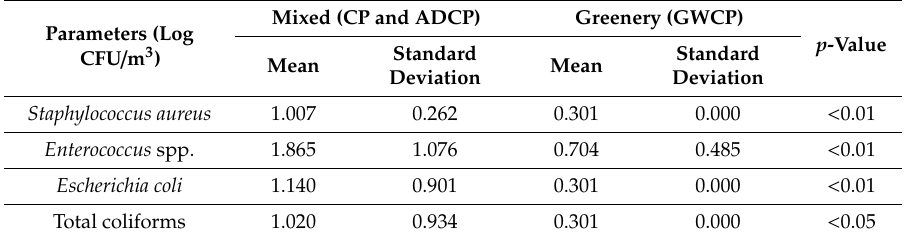
Table 4. Descriptive analysis of statistically significant biological parameters in relation to treated waste typology. Mixed = 10 plants, greenery = 1 plant. CFU = colony forming